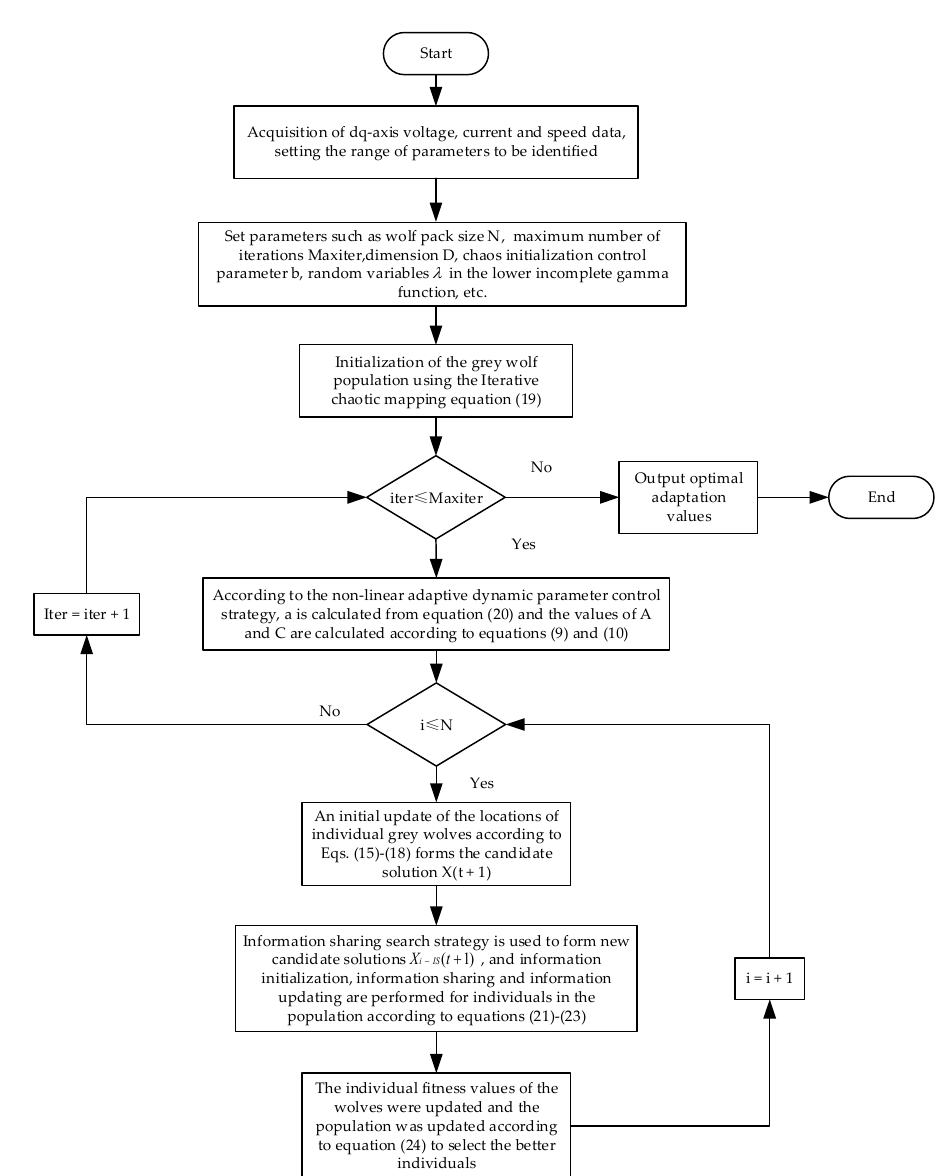
Figure 11. Flow chart for parameter identification based on ISIAGWO algorithm.